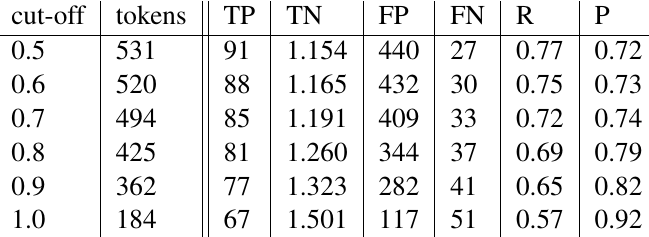
Table 5: Prediction performance of the IDPredictor classifier for UniProt entry CP20C ARATH. The columns cut-off, tokens, TP, TN, FP, FN, R and P are the p-value cut-off for the predicted ID tokens, the number of ID tokens has better p-value than the cut-off, the true positives, true negatives, false positives, false negatives, recall and precission cut-off